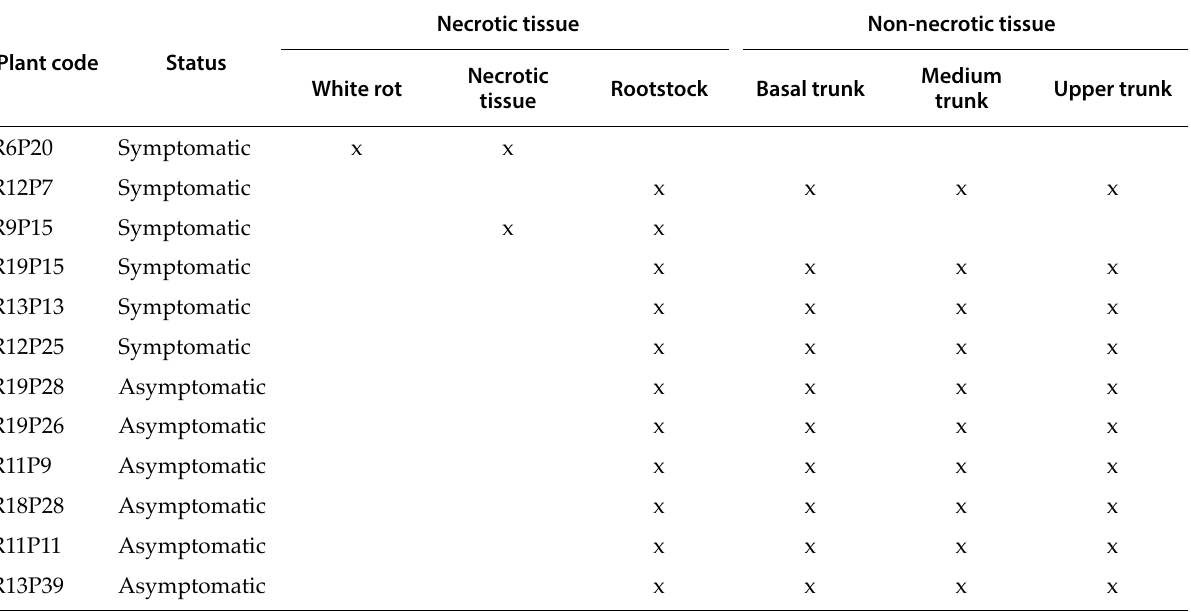
Table 1. Status of the grapevine wood tissues sampled from symptomatic and asymptomatic ‘Cabernet Sauvignon’ grape-